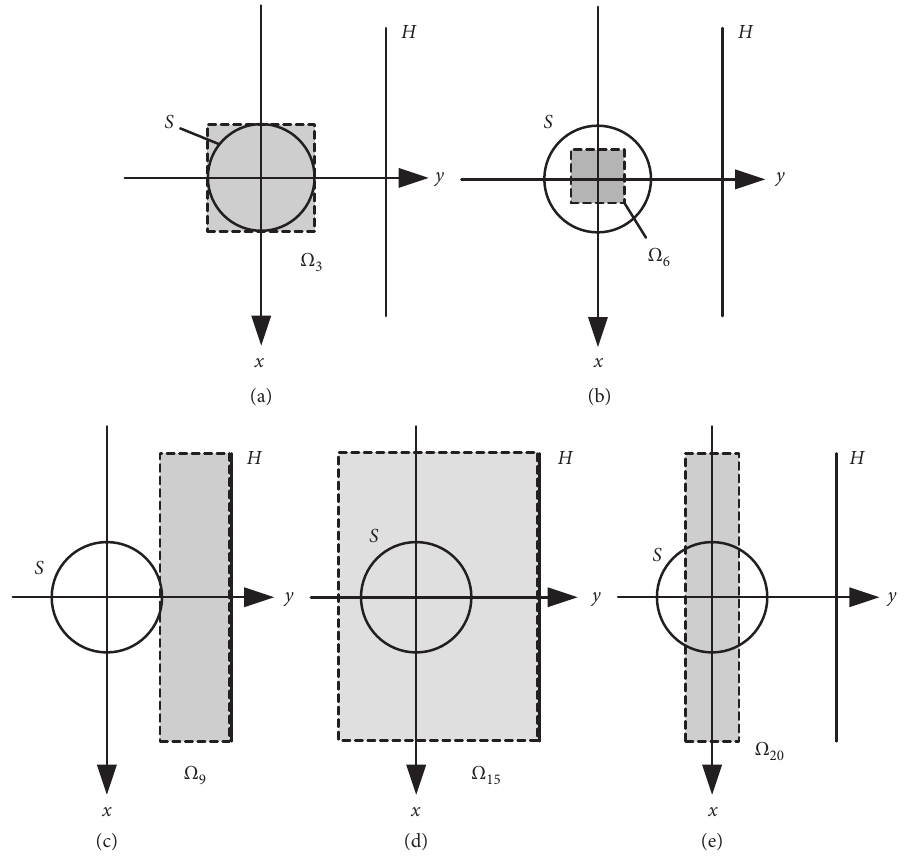
Figure 3: Geometric sketch of the fictitious surface Ω .